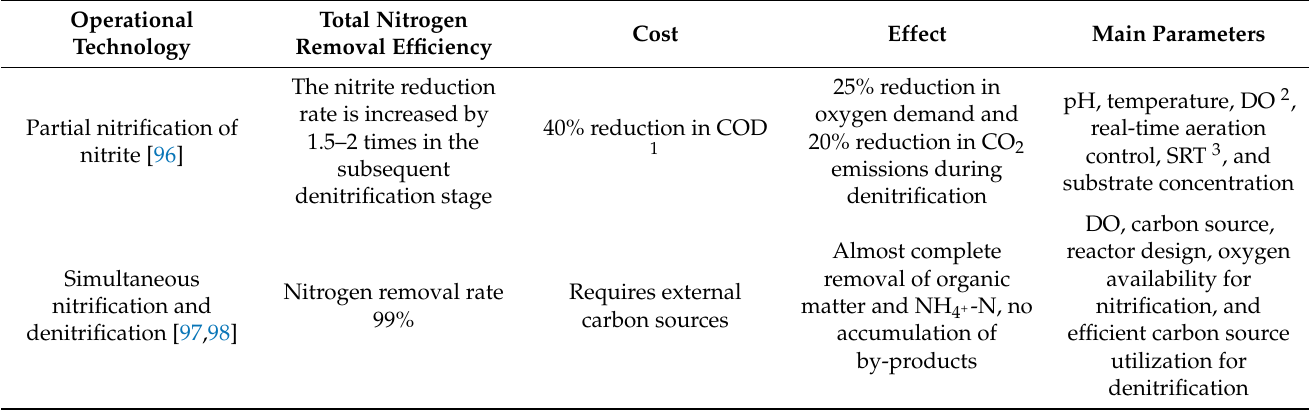
Table 2. Comparison of various indicators among various denitrification and conventional treatment